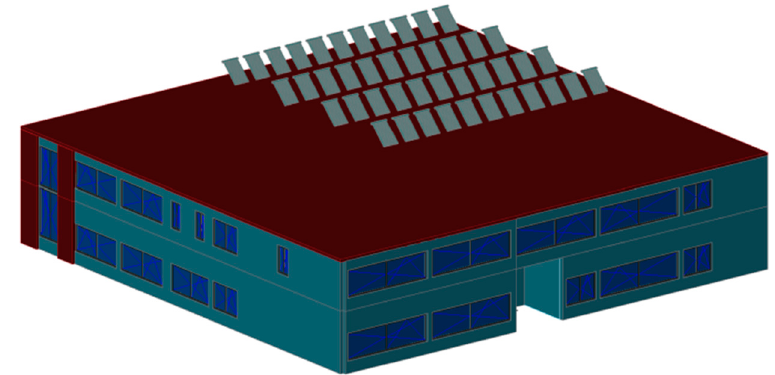
Figure 1. The 3D drawing of the building equipped with solar thermal collectors.